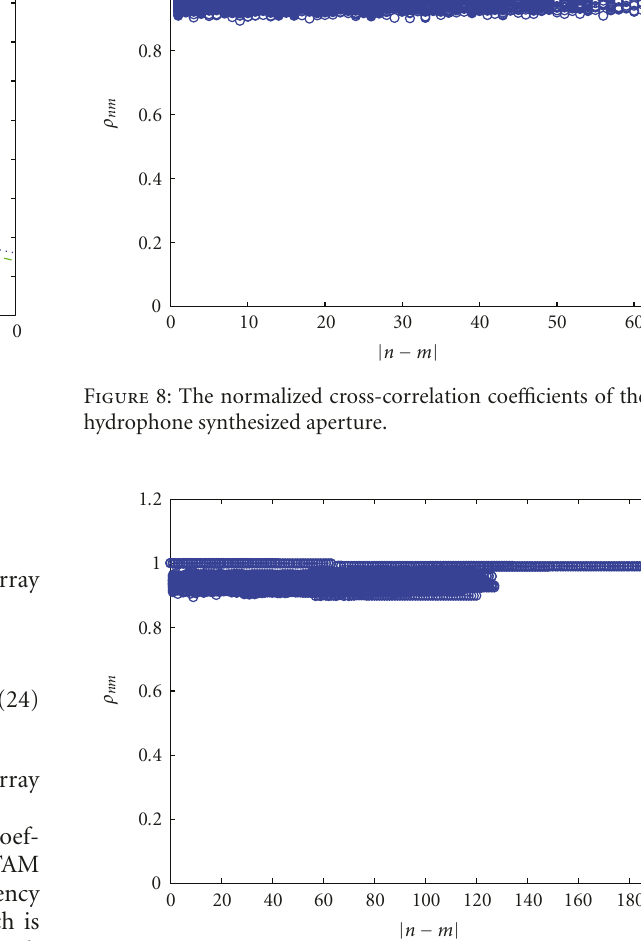
Figure 9: The normalized cross-correlation coe ffi cients of the 192- hydrophone synthesized